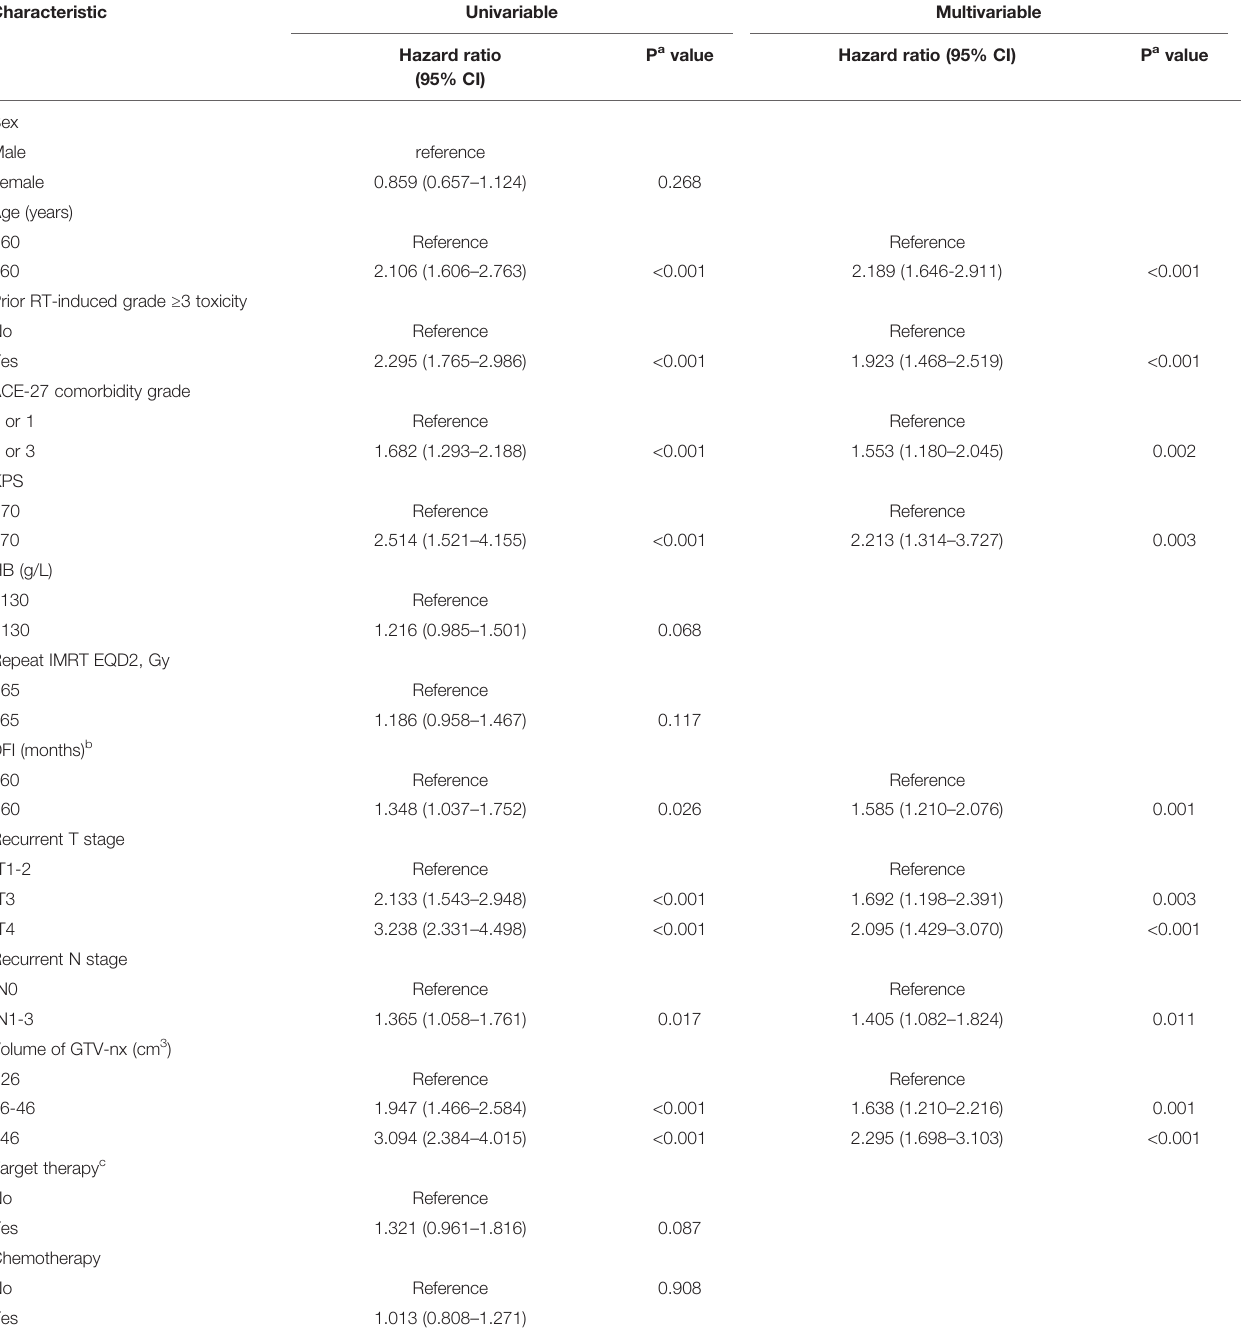
TABLE 2 | Univariable and multivariable